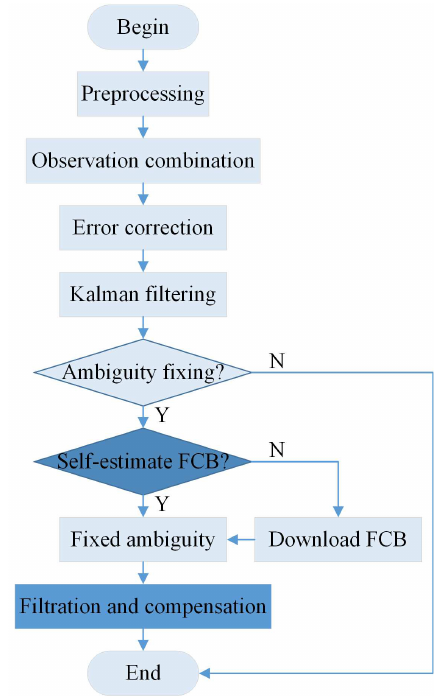
Figure 1. The flowchart of precise point positioning (PPP)-partial ambiguity resolution (PAR) without